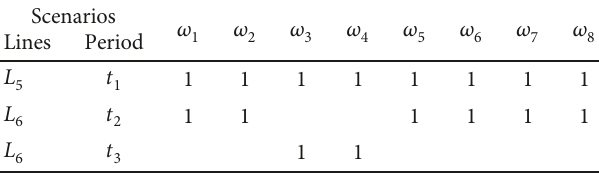
Table 6: Transmission lines installed during the planning